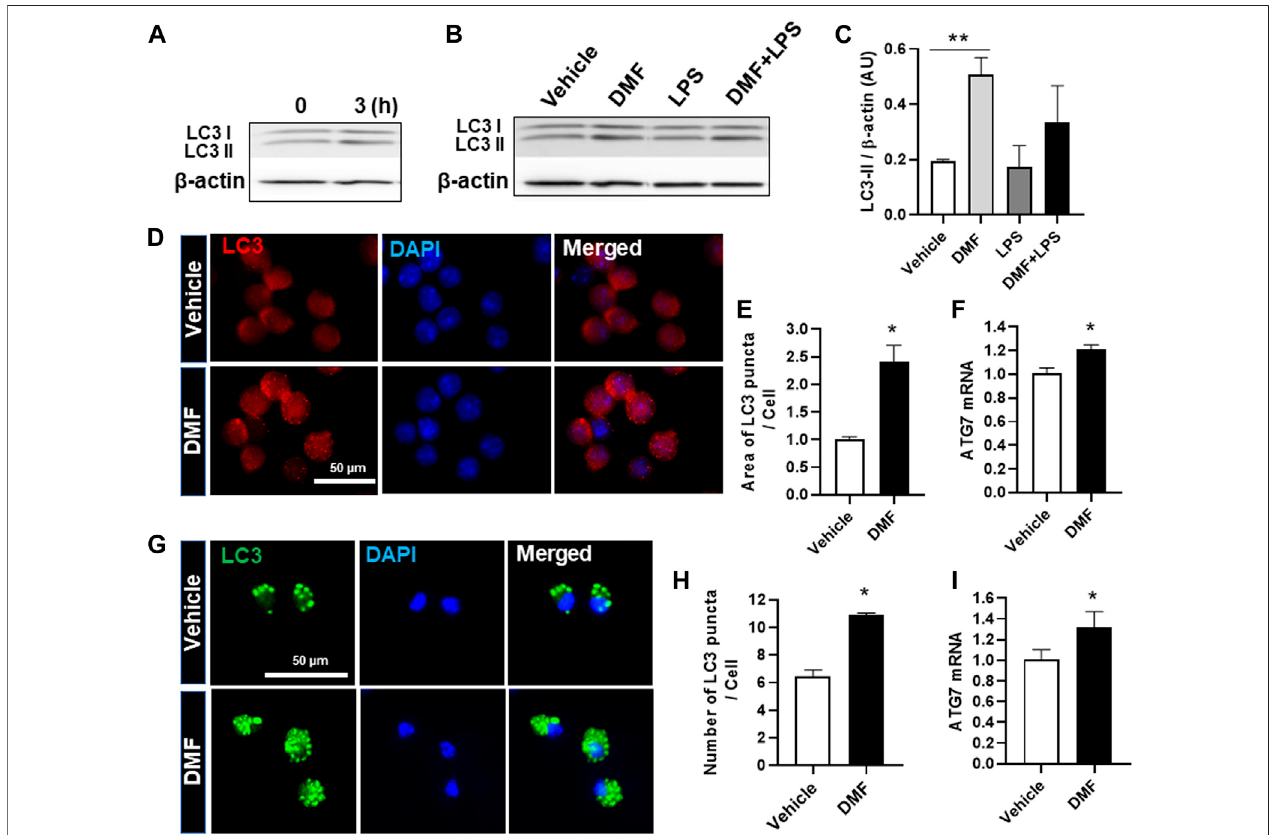
FIGURE 4 | DMF increases autophagy in microglia. HAPI cells were seeded at 2.5 × 10 5 cells/well in a 6-well plate and incubated overnight (A) Cells were then treated with DMF (4 μ M) for 3 h (B) Cells were treated with LPS (100 ng/ml) or DMF (4 μ M) plus LPS (100 ng/ml) for 24 h. The protein levels of LC3-I and LC3-II were determined by Western blot analysis. β -actin was used as the loading control. n (cid:2) 3 independent experiments/group (C) Histogram shows the densitometric analysis of Western blots. β -actin was used as the loading control and data were normalized to total β -actin (D) HAPI cells were seeded at 2 × 10 4 cells/well in a 24-well plate and incubated overnight. Cells were then treated with DMF (4 μ M) for 24 h and stained with the anti-LC3 antibody (E) The punctate area was determined from at least 3 independentimages(Vehicle:29cellsandDMF:26cells)usingImageJandwasexpressedastheratioofvehiclecontrols (F) HAPIcellswereseededat1 × 10 6 cells/well in a 6-well plate and incubated overnight. Cells were then treated with DMF (4 μ M) for 6 h. The mRNA expression levels of Atg7 was determined by RT-qPCR. Fold changes were calculated as the ratio of expression level in untreated control cells (G) Primary microglia isolated from MGC were seeded at 5 × 10 4 cells/well in a 24-well plateand incubated overnight.CellswerethentreatedwithDMF(10 μ M) for24 h, followedbystainingwiththeanti-LC3antibody (H) Thenumber ofLC3punctaper cell was counted. A total of 27 control cells and 38 DMF-treated cells were analyzed (I) MGC were seeded at 2 × 10 5 cells/well in a 12-well plate and incubated overnight. Cells were then treated with DMF (10 μ M) for 6 h. The mRNA expression levels of Atg7 was analyzed by RT-qPCR. Fold changes were calculated as the ratio of expression levelin untreated control cells. n (cid:2) 3independent experiments/group.Dataarepresentedasmeans ± SEM. * P < 0.05from Student ’ s t -test forindicatedtwo groups. ** P < 0.01 compared with vehicle from ANOVA, Tukey ’ s multiple comparison